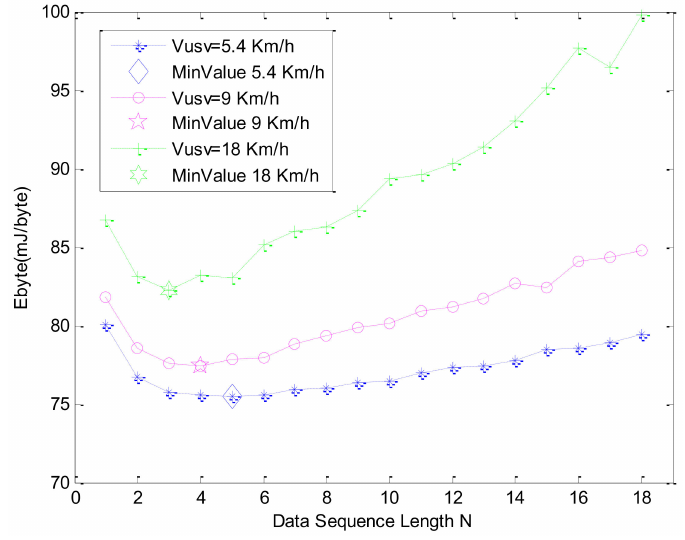
Figure 11. Energy consumption simulation for data sequence length N and velocity of